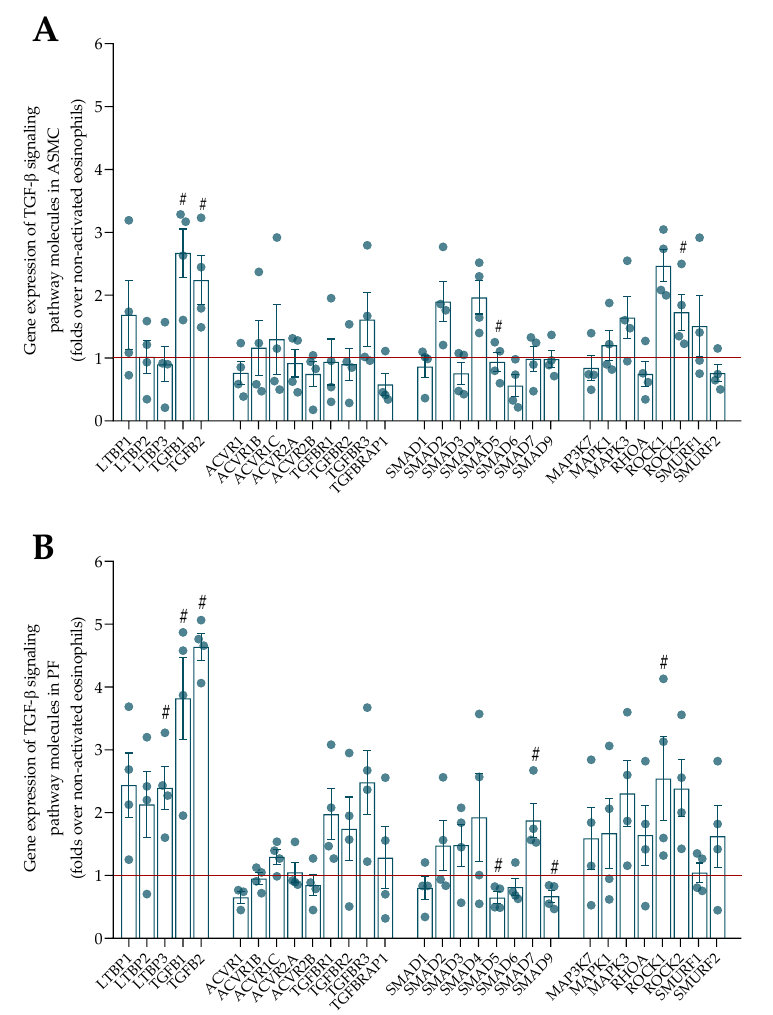
Figure 6. ( A )—Gene expression of TGF- β signaling pathway molecules in ASMC after incubation with allergen-activated eosinophils; ( B )—Gene expression of TGF- β signaling pathway molecules in PFafter incubation with allergen-activated eosinophils. AA, n = 4, SNEA, n = 4, HS, n = 4. Data are presented as fold change over the non-activated AA eosinophil effect, mean ± SEM. # p < 0.05 compared with non-activated eosinophil effect. Statistical analysis between investigated groups—Wilcoxon signed-rank test was used for gene expression analysis against control ASMC or PF that were not incubated with eosinophils.